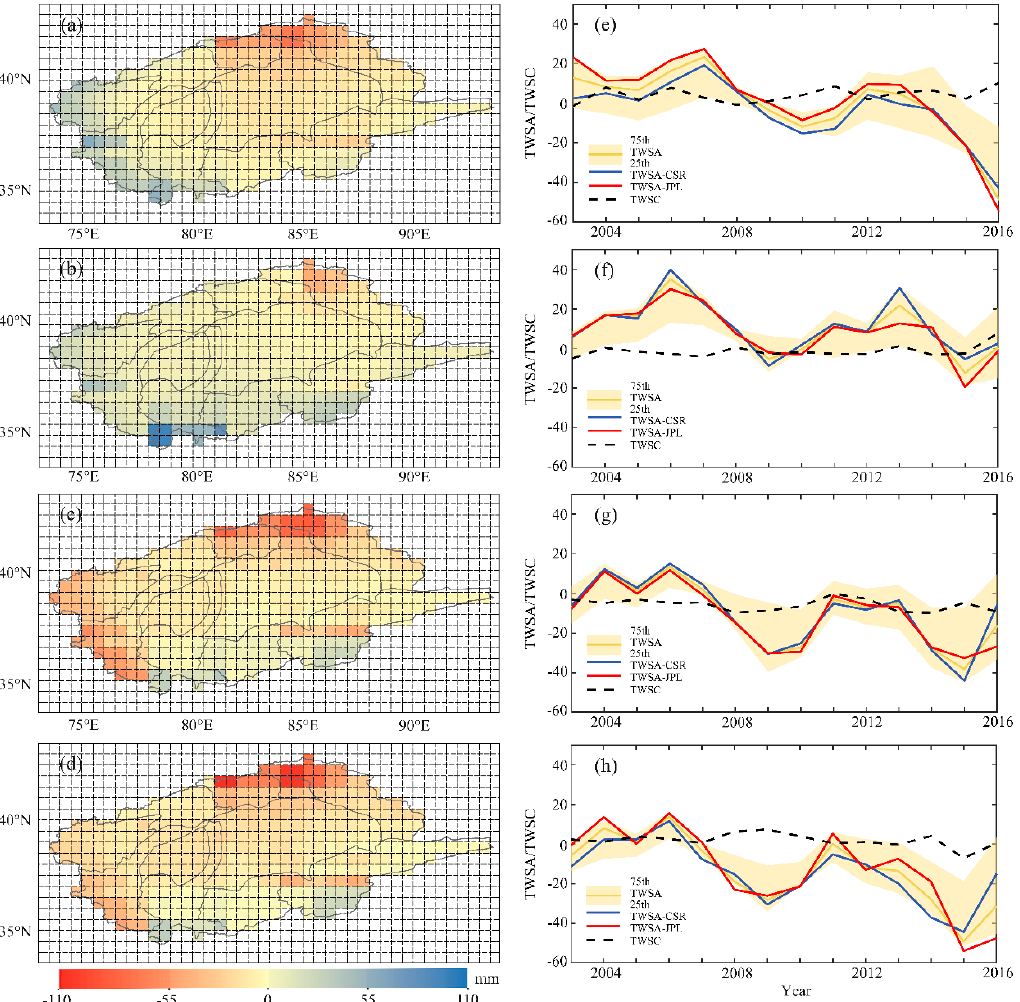
Figure 5. The spatial–temporal distribution of the mean TWSA(mm) in different seasons from April 2002 to January 2017, ( a , e ) Spring (March–May), ( b , f ) Summer (June–August), ( c , g ) Autumn (September–November), and ( d , h ) Winter (December–February) in the Tarim River basin (TRB).